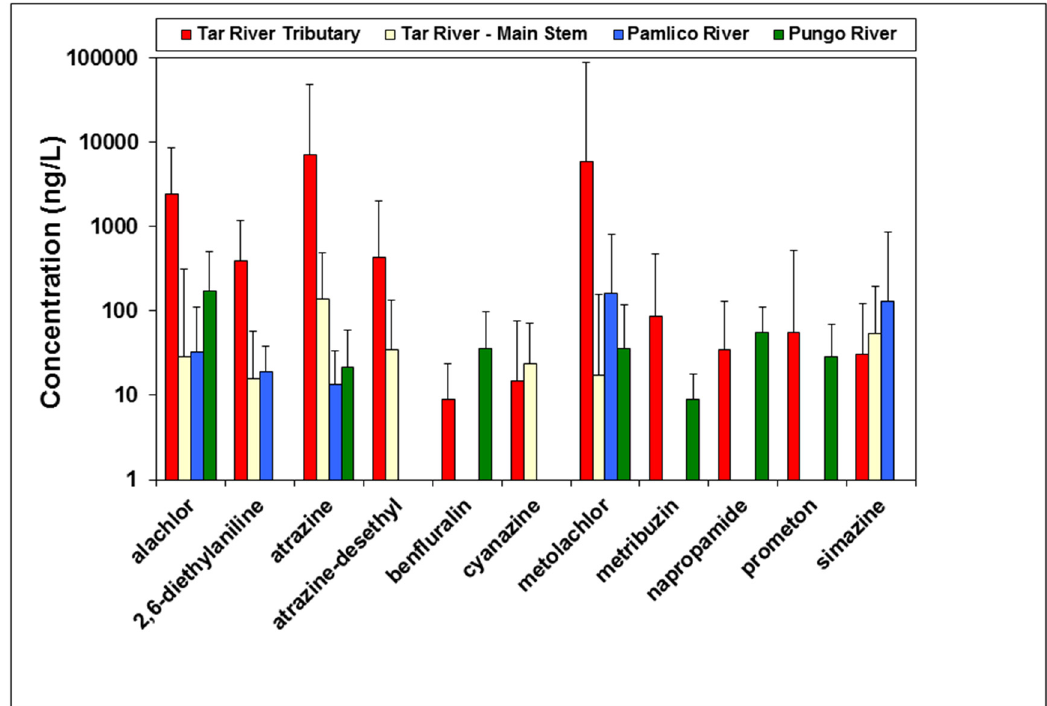
Figure 2. Geometric mean and maximum (denoted by top of range bar) herbicide and metabolite concentrations (ng/L) measured in samples of surface water collected in the Tar River tributaries, Tar River mainstem, Pamlico River, and Pungo River in 2000. Data are not shown where herbicide concentrations were not detected (below 1 ng/L).